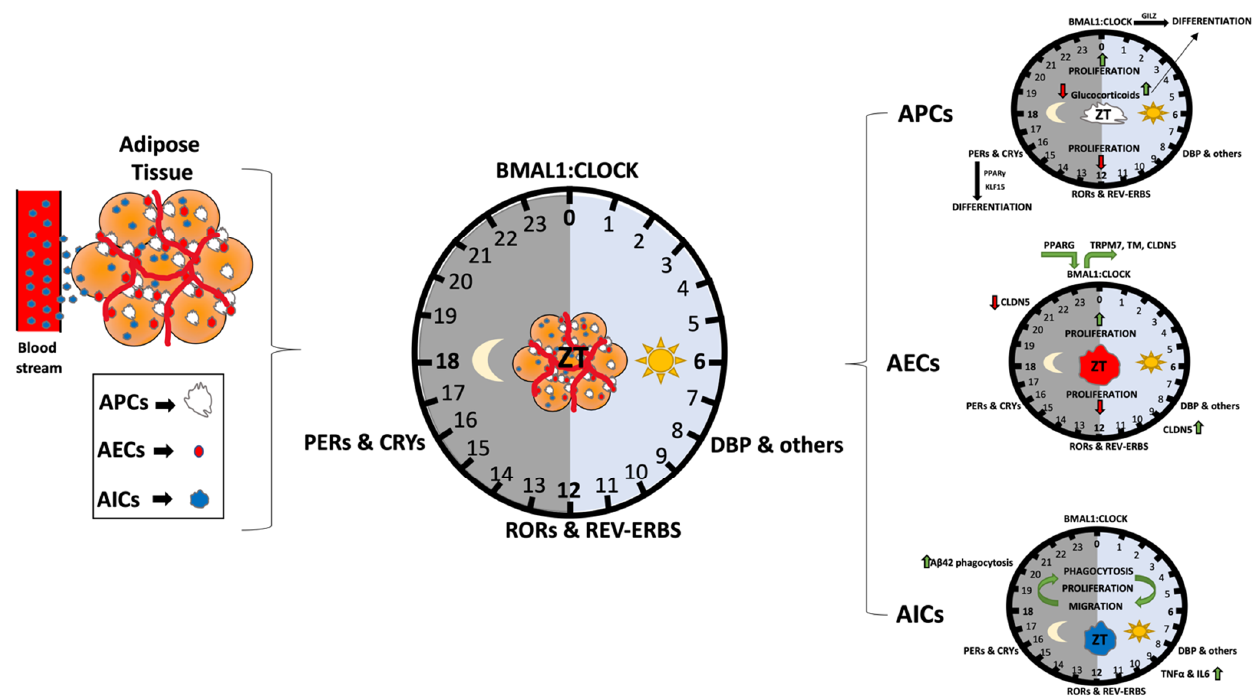
Figure 2. Circadian regulation of adipose tissue and its resident cells. Adipose tissue composition includes mature adipocytes (yellow), and cells of the stromal vascular fraction (SVF), which include immune cells (AIC), endothelial cells (AEC) as well as adipocyte progenitor cells (APCs), which can undergo adipogenesis to become mature adipocytes. Collectively, these cells are controlled in part by circulating factors that access adipose tissue via the vasculature ( left ). Specific circadian cues known to be important for adipose tissue biology include glucocorticoids and PPARγ (which regulate pre-adipocyte differentiation), as well as clock genes themselves, which can control proliferation and function of specific SVF cells through regulation of CLOCK:BMAL1-target genes ( right ). The BMAL1-target gene CLDN5, a tight function protein expressed in endothelial and epithelial cells, is known to be rhythmic and important for some microvascular function. In addition to immune cell regulation by clock genes, the proinflammatory cytokines, TNFα and IL6, are also clock-controlled, and can modulate the activity of immune cells such as